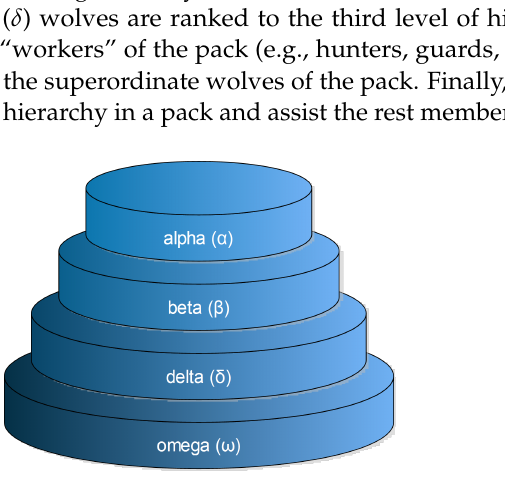
Figure 1. Social hierarchy classification of grey wolves.